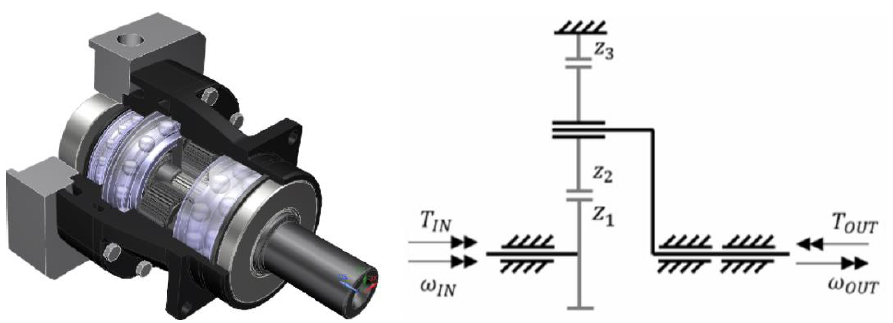
Figure 3. Geometrical model of the analyzed gearbox. Table 1. Material and geometrical properties of the gearbox.